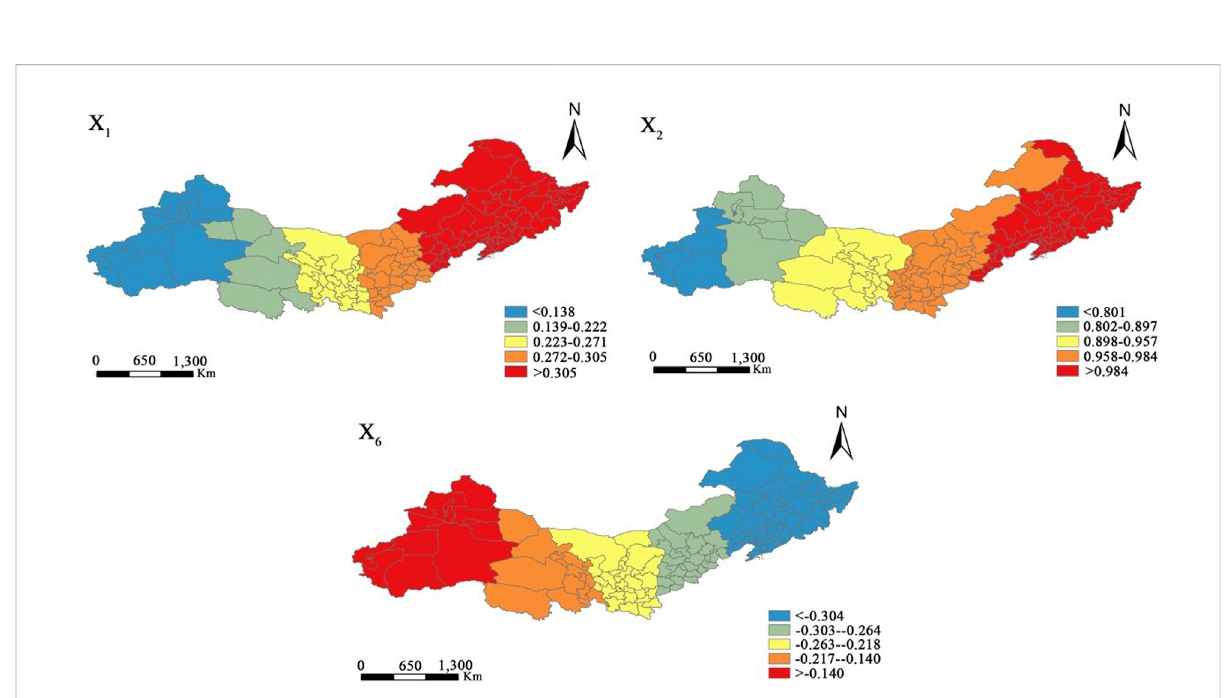
FIGURE 8 Spatial Distribution of Regression Coef fi cients of the GWR Model